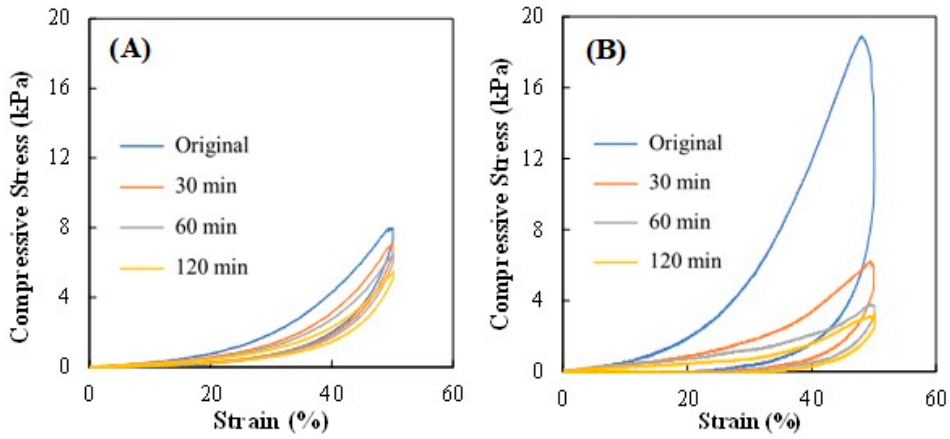
Figure 3. Loading–unloading curves of ( A ) Na5 1 * 4 and ( B ) Na5 1 * 6 hydrogels, under 50%